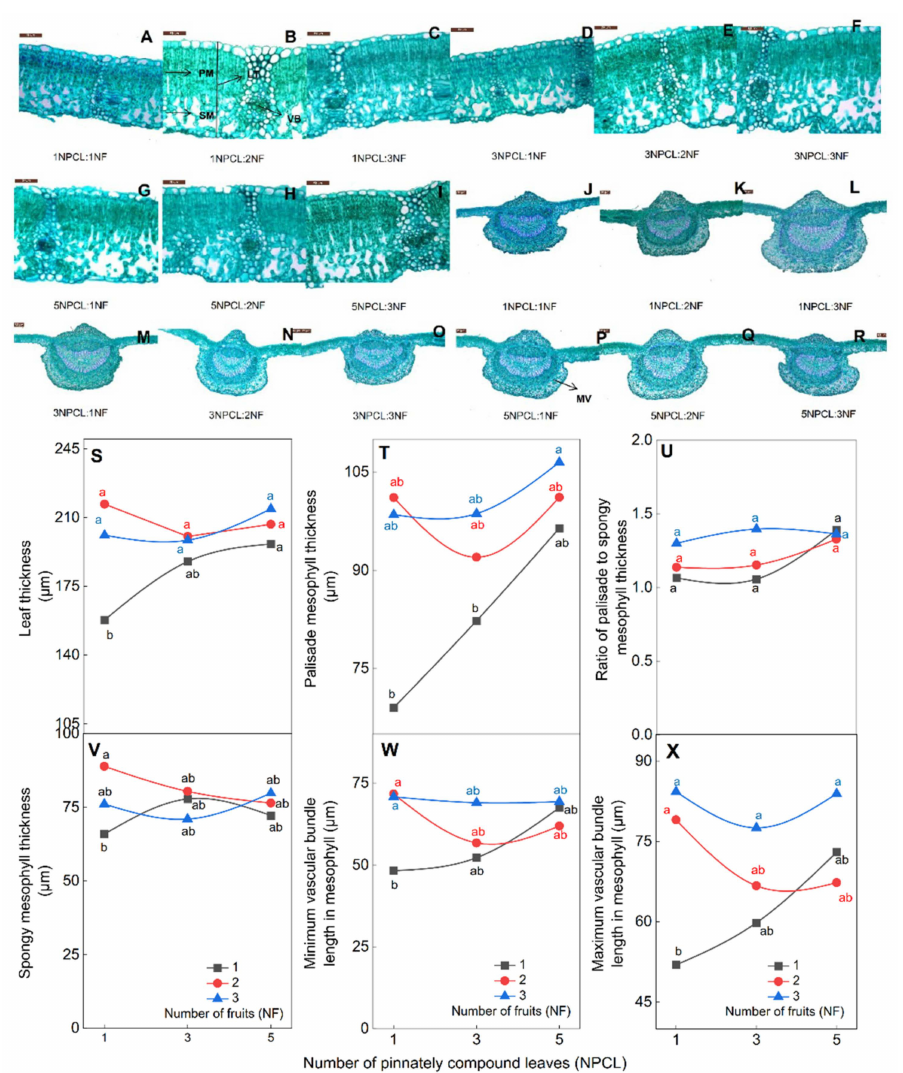
Figure 6. Effects of the source–sink relationship on leaf anatomical structure. Shown ( A – I ) are the development diagrams under the 40 × objective lens field of view. Shown ( J – R ) are the development diagrams of the main veins of leaves under the 2.5 × objective lens. MV, main vein; VB, vascular bun- dle; PM, palisade mesophyll; SM, spongy mesophyll. Different lowercase letters indicate significant ( p < 0.05) differences between branches with different leaf-to-fruit